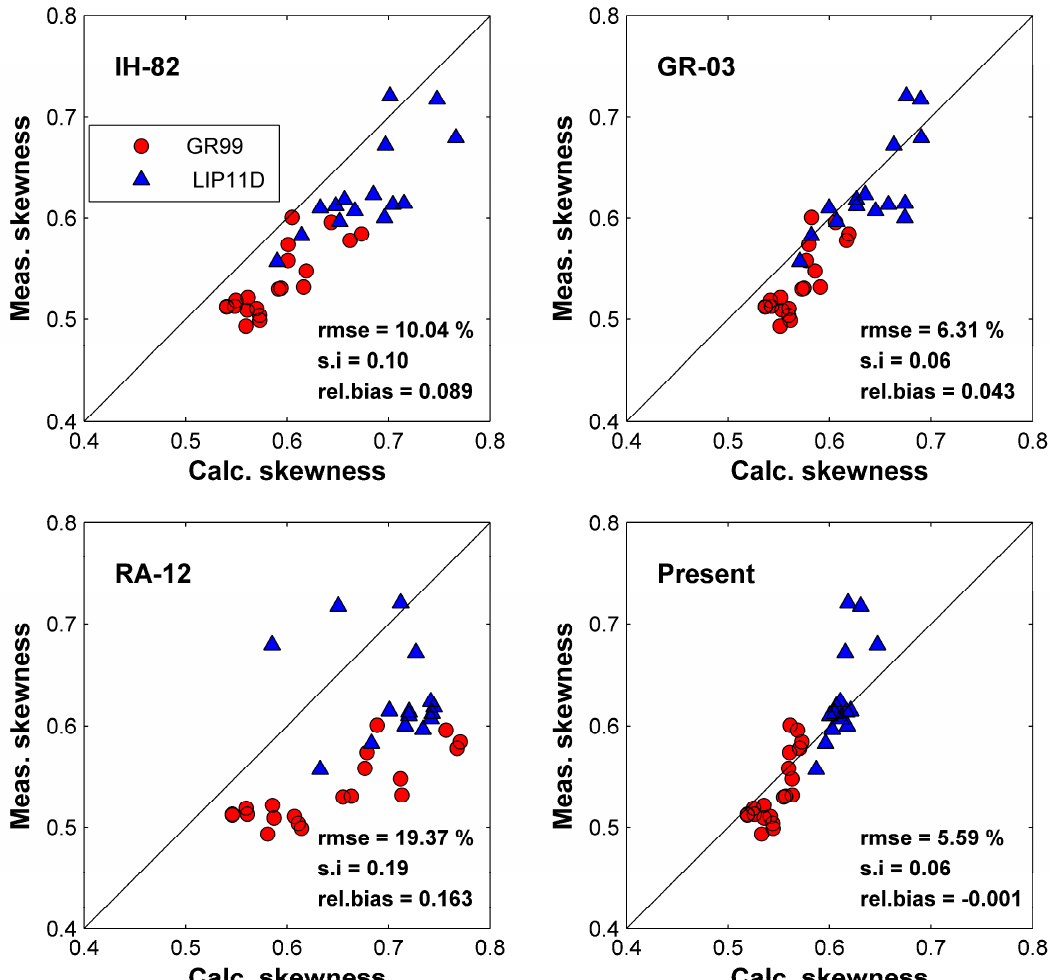
Figure 13. Predicted skewness using four employed formulas and measured skewness for GR99 and LIP11D data.